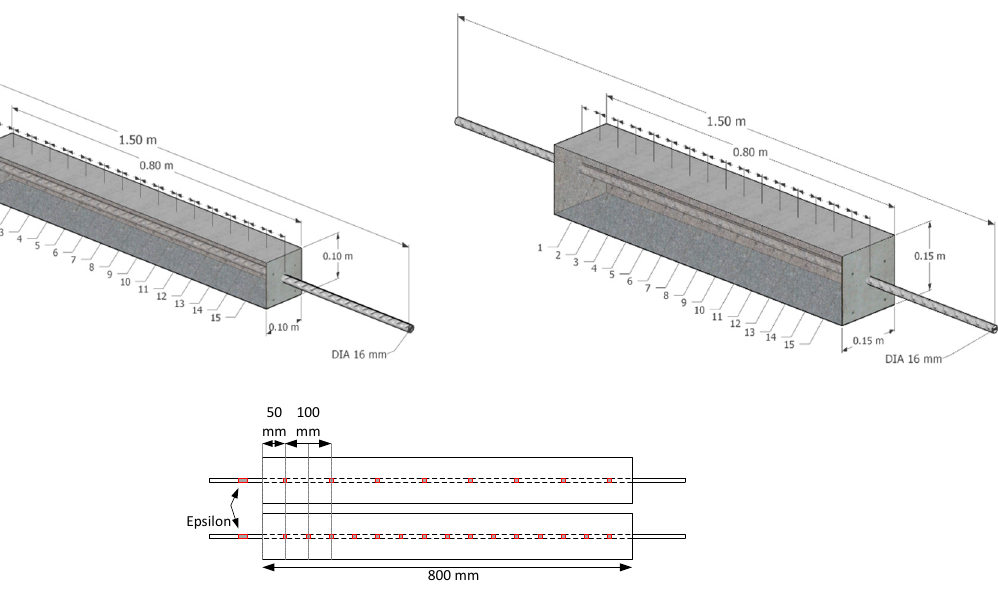
Figure 4. Geometry of specimens with locations of installed strain gauges.